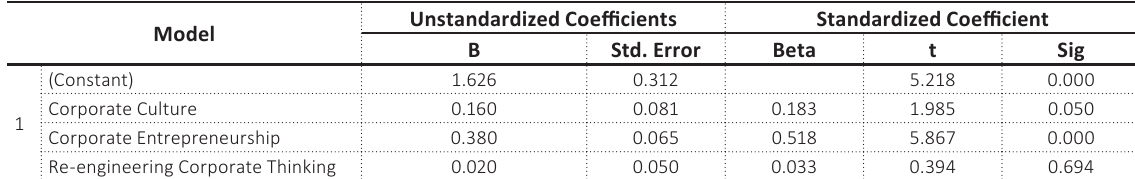
Table 5. Regressing intrapreneurship sub-variable against OJO performance (ANOVA) Model